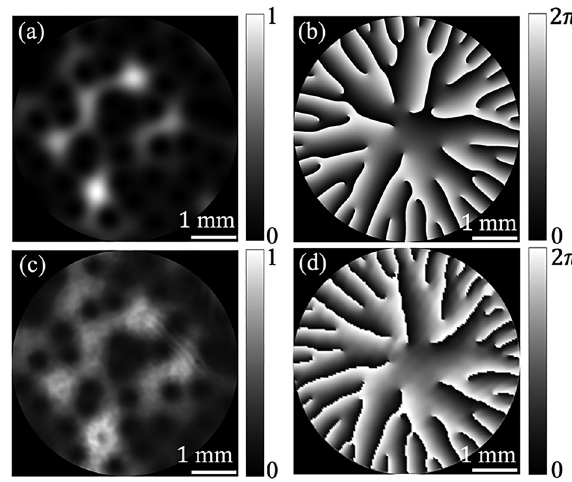
Figure 1: Theoretical results of the (a) intensity distribution and (b) phase distribution of one realization (instantaneous electric fi eld). (c) and (d), the corresponding experimental results of the intensity distribution and phase